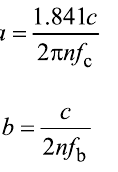
growth temperature ( T 1 = 1223 K, for square-shaped NWs and T 2 = 1273 K, for cylindrical-shaped NWs). Again, r 1 (r 2 ) and L 1 ( L 2 ) are the width (radius) and length of rectangular (column) shape nucleus. δ 1 ( δ 2 ) and ( ) are the nucleus vapor inter- face energy and nucleus–liquid interface energy for rectangular (column) shaped nucleus, respectively. Optimizing Equation